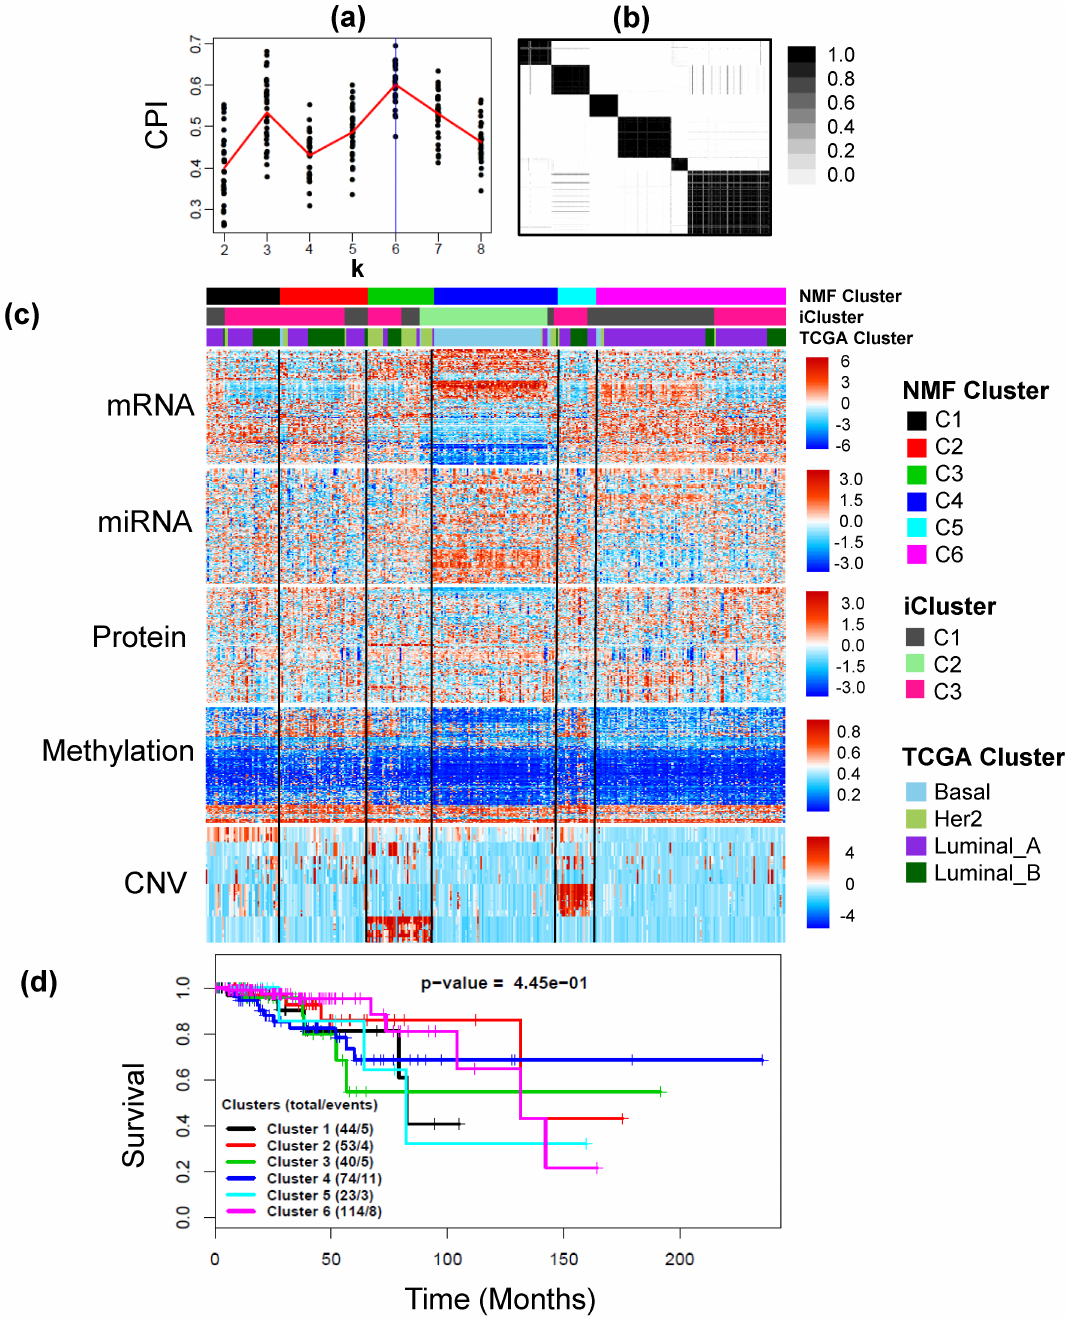
Fig 3. Example 1: Breastcancer data. (a) Plot of CPI over the search range of number of clusters from 2 to 8 for 30 runs of intNMF algorithmat each k . The red line represents the mean values of CPI at each k . (b) The cluster pattern as shown by the consensusmatrix. (c) Heatmap of five types of data, mRNA, miRNA (log transformed and scaled), Protein, Methylation and CNV with clusteringassignmentfrom intNMF and TCGA subtypesoverlaidon top with legendson the side. (d) Kaplan Meier Survival curves with p-value from